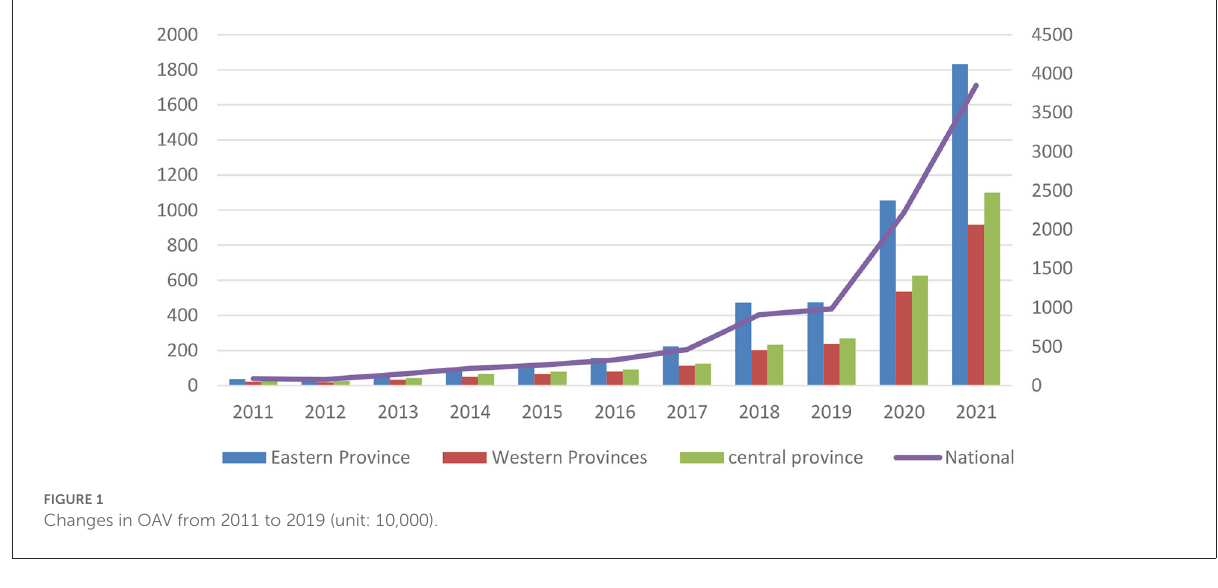
TABLE 1 OAV in each month in China between 2011 and 2019 (unit: